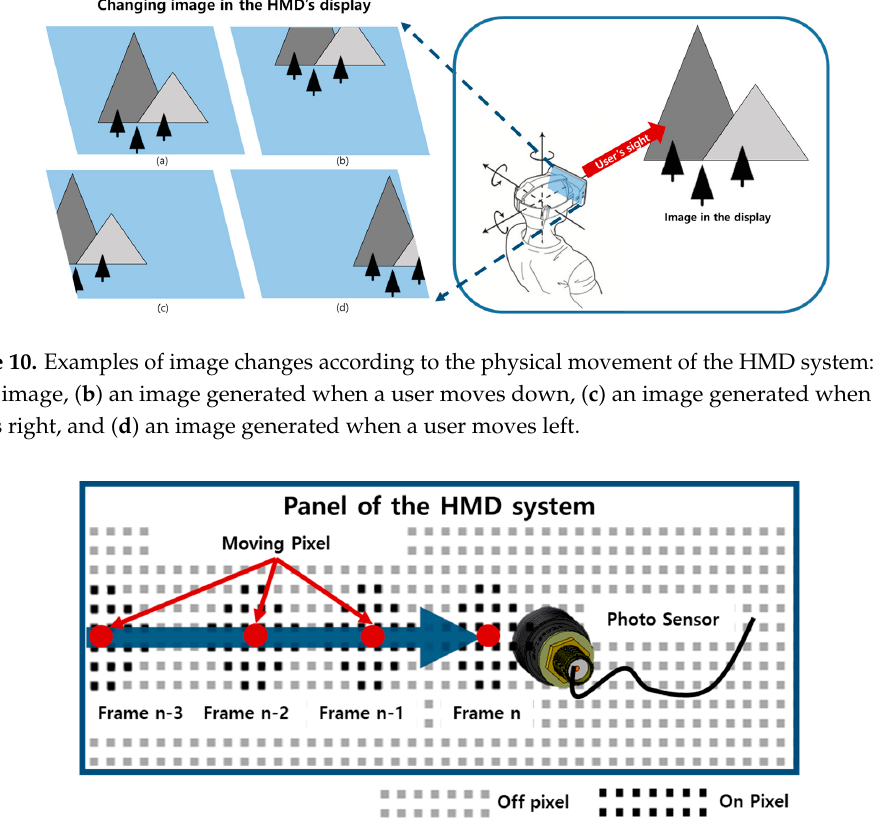
Figure 11. Operation process of the pixel luminance change measurement method.